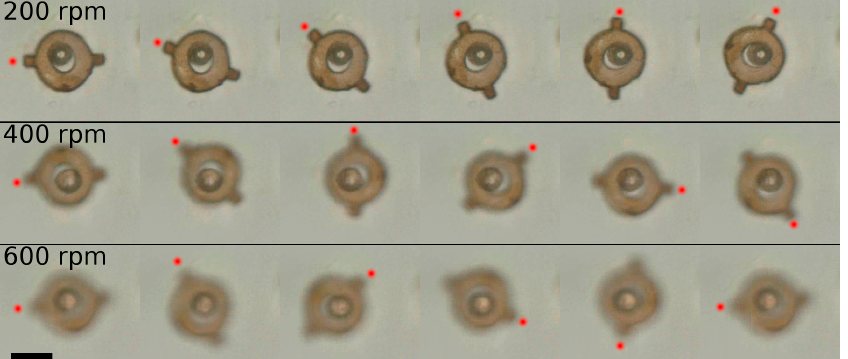
Figure 6. Subsequent frames recorded at 50 fps with stirrer rotation speed set to 200 rpm (first row), 400 rpm (second row), and 600 rpm (third row). Rotation is clockwise, red dots added manually as a visual hint. Scale bar is 20 µm. A short video of rotation at different speeds is available in Video S1.